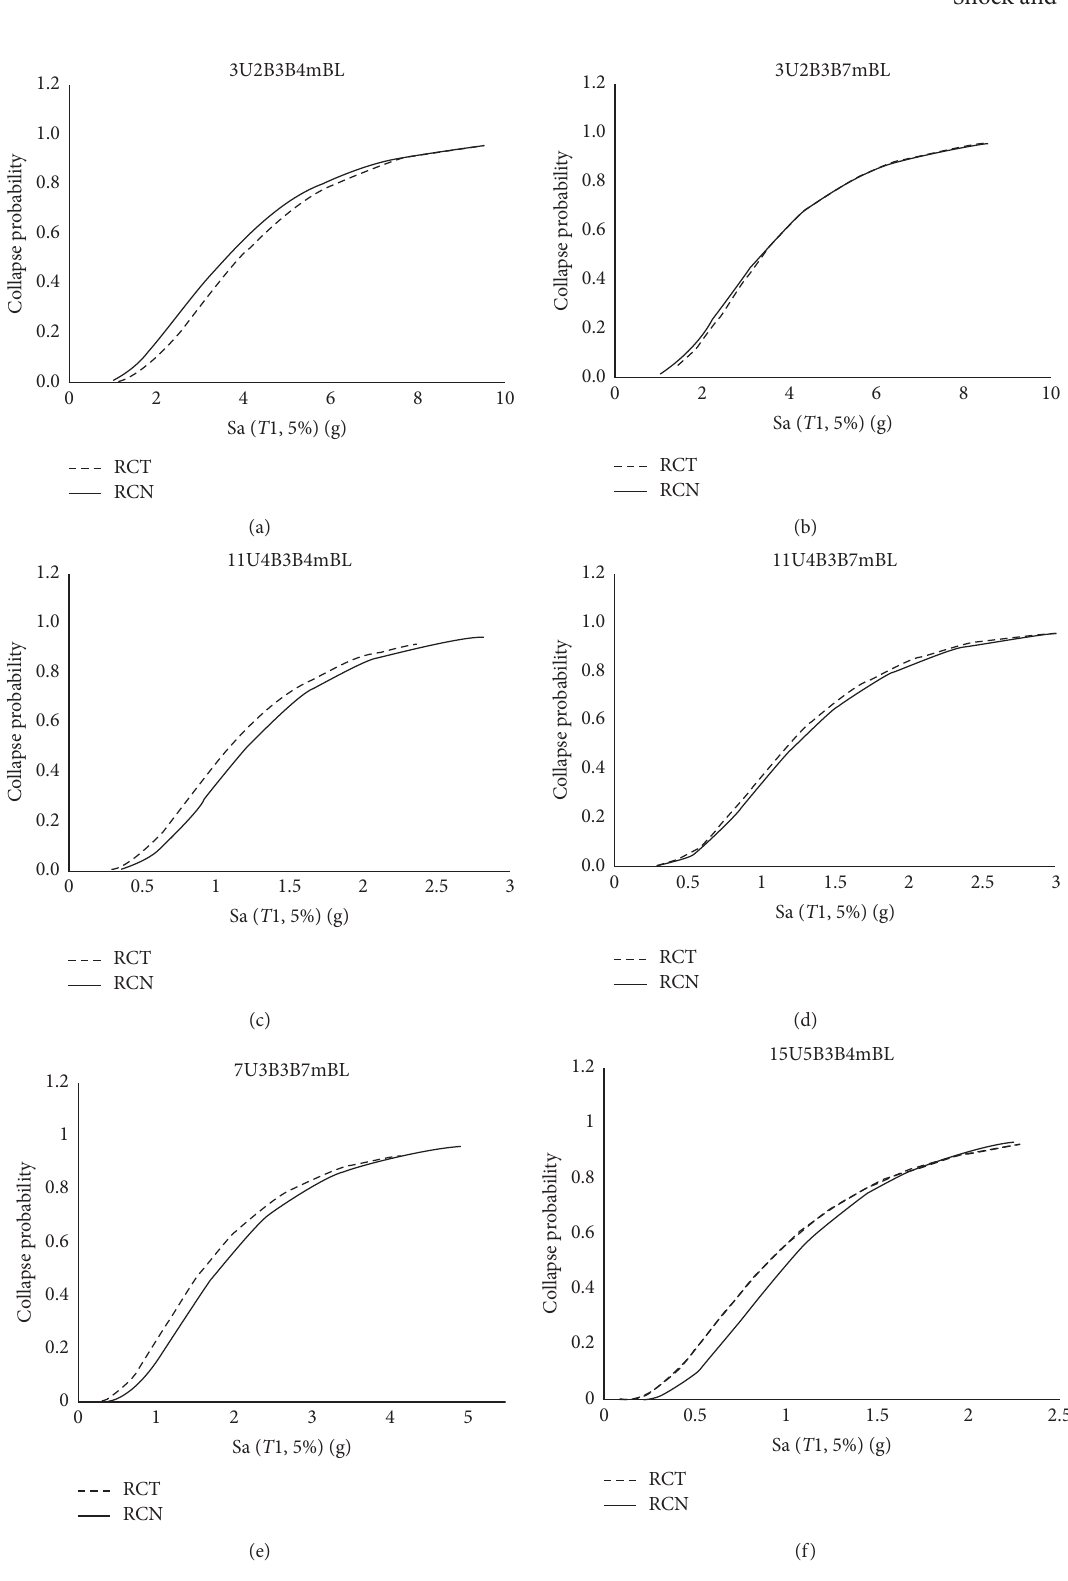
Figure 9: Fragility curves of some archetypes as samples for RCN and RCT